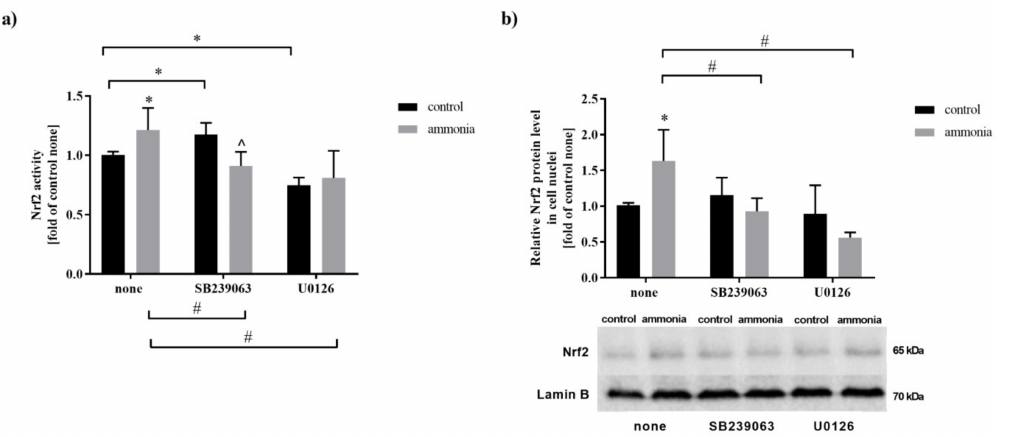
Figure 1. The effect of MAPK, and MEK1/2 inhibitors in the absence or presence of ammonia on the Nrf2 activity and Nrf2 nuclear protein level. ( a ) Nrf2 activity in mouse cortical astrocytes after exposure to ammonia, MAPK, and MEK1/2 inhibitors. Results are the mean ± SD ( n = 4). (*) p < 0.05 vs. control none; (#) p < 0.05 vs. ammonia none; (ˆ) p < 0.05 vs. control SB239063; two-way ANOVA, Bonferroni post hoc test. ( b ) Nrf2 protein level in cell nuclei of mouse cortical astrocytes after exposition to ammonia, MAPK, and MEK1/2 inhibitors. Results are the mean ± SD ( n = 4). (*) p < 0.05 vs. control none; (#) p < 0.05 vs. ammonia none; (ˆ) p < 0.05 vs. control SB239063; two-way ANOVA, Bonferroni post hoc